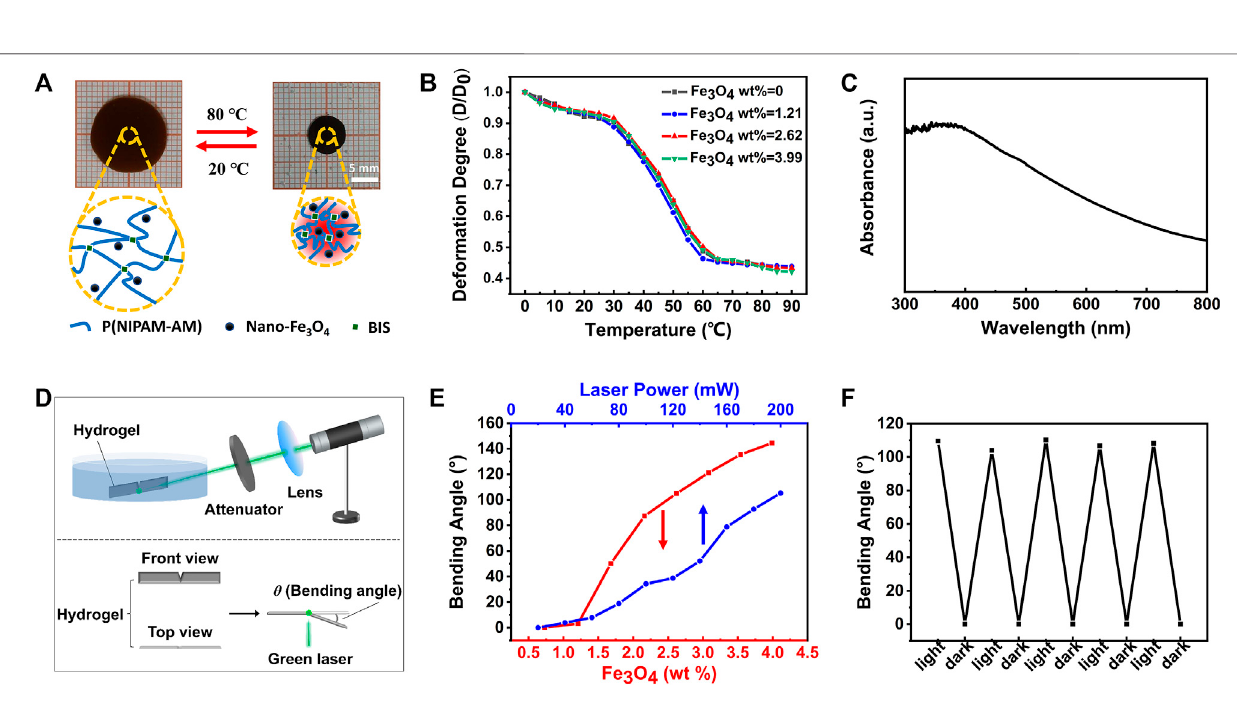
FIGURE 3 | (A) Optical images of P(NIPAM-AM)/Fe 3 O 4 hybrid hydrogel with 2.62 wt% Fe 3 O 4 NPs in water at 20 and 80 ° C with the corresponding schematic diagram of deformation mechanism. (B) Deformation degree as a function of temperature for hydrogels with different contents of Fe 3 O 4 NPs. (C) UV − Vis absorbance spectrum of surface-modi fi ed Fe 3 O 4 NPs/DMSO solution. (D) Schematic of the experimental device and 3D hydrogel model for measuring photo-responsive deformation of the hybrid hydrogel. (E) Dependences of laser power and contents of Fe 3 O 4 NPs on the bending angle of the hydrogel strip. (F) Plot of changes in maximum bending angles over fi ve light − dark cycles. Scale bar of (A) is 5